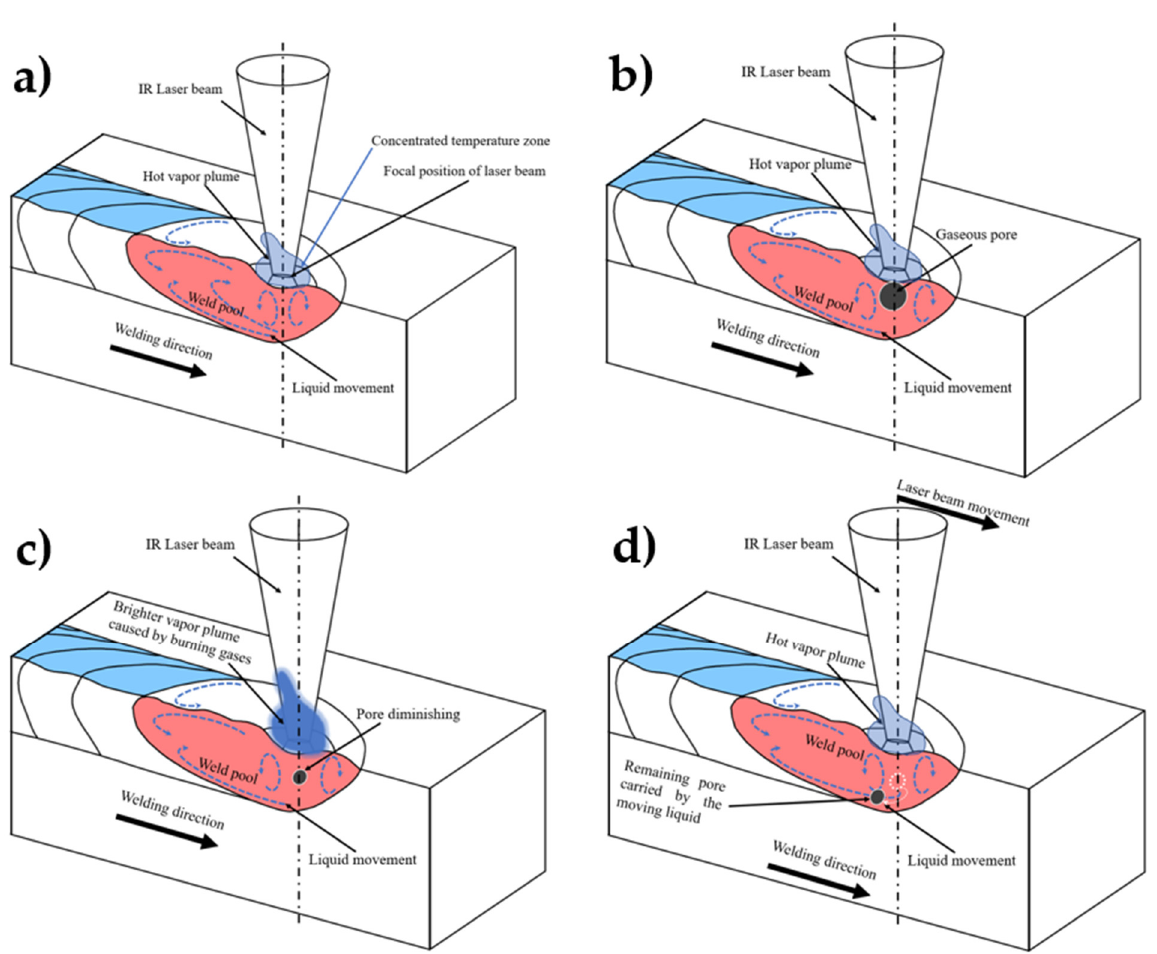
Figure 11. Schematic representation of hot vapor plume increased intensity: ( a ) liquid movement, ( b ) pore gases being burned, ( c ) formation of a smaller spherical pore and ( d ) entrapped pore by fast solidification.